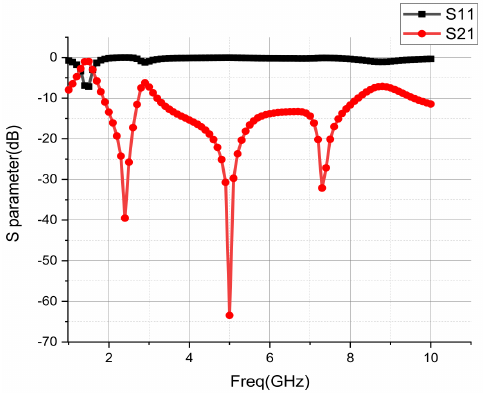
Figure 4. S parameter simulation of the three-band elimination filter.